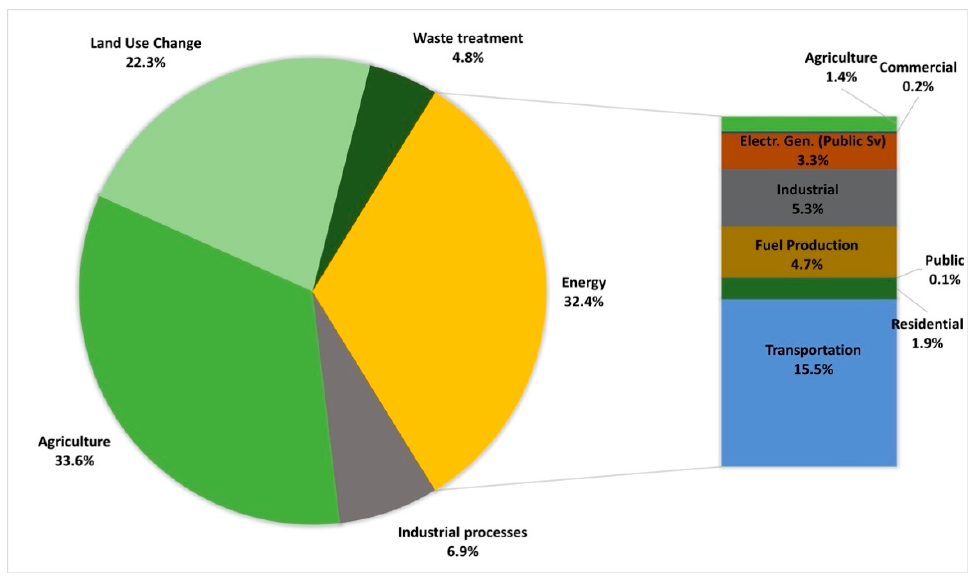
Figure 1. Total net emissions in 2016—1305.6 million tons of CO2-eq. Data Source: [6,7].